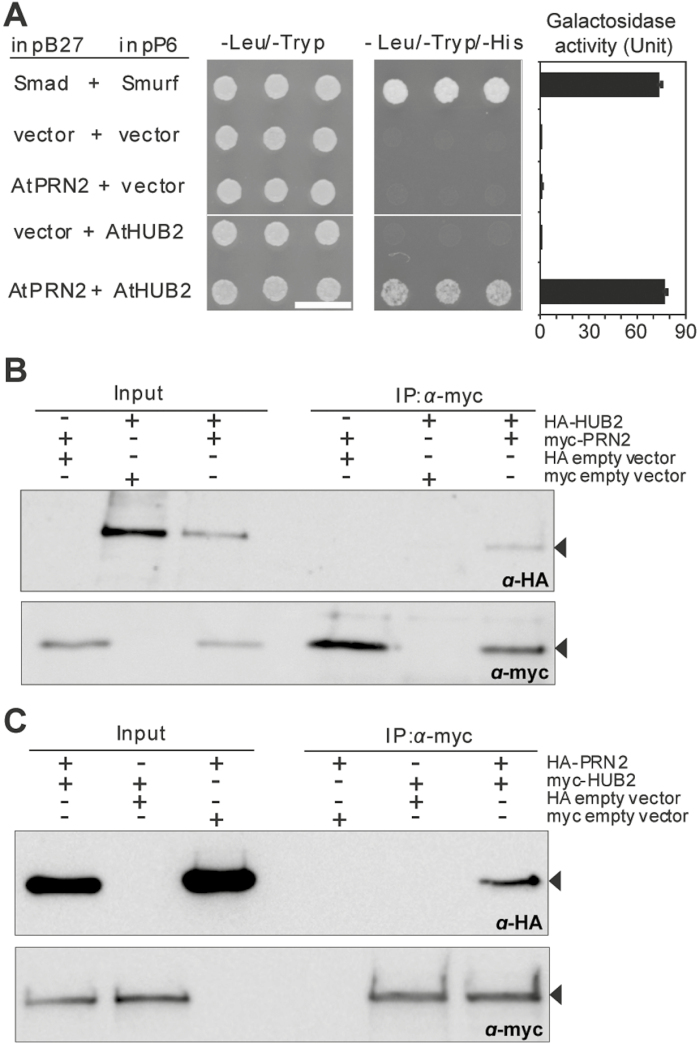
PRN2 interacts with HUB2. (A) Visualization of protein–protein interactions by yeast two-hybrid assay. The interaction of PRN2 with HUB2 was assessed by growth on plates with yeast growth medium lacking leucine, tryptophan, and histidine (-Leu/-Trp/-His). The two human proteins Smad+Smurf [encoding fusion protein LexA–Smad (pB27-Smad) and GAL4AD–Smurf (pP6-Smurf), respectively] were used as a positive control. The empty vectors pB27+pP6 vector, pB27-PRN2+empty pP6, and empty pB27+pP6-HUB2 were used as negative controls. Scale bar=1 cm. Activation of a second reporter gene (β-galactosidase) is shown to the right with a column chart. (B, C) Co-immunoprecipitation assays (co-IP) with anti-myc antibodies and detection by western blotting using anti-HA. Anti-myc monoclonal antibody co-immunoprecipitated HA-tagged HUB2 protein along with myc-PRN2 (B) and HA-tagged PRN2 along with myc-HUB2 (C). Inputs represent concentrated proteins in crude extracts. The labelled bands indicated by arrowheads refer to the co-precipitated HA-HUB2 (B) or HA-PRN2 (C).